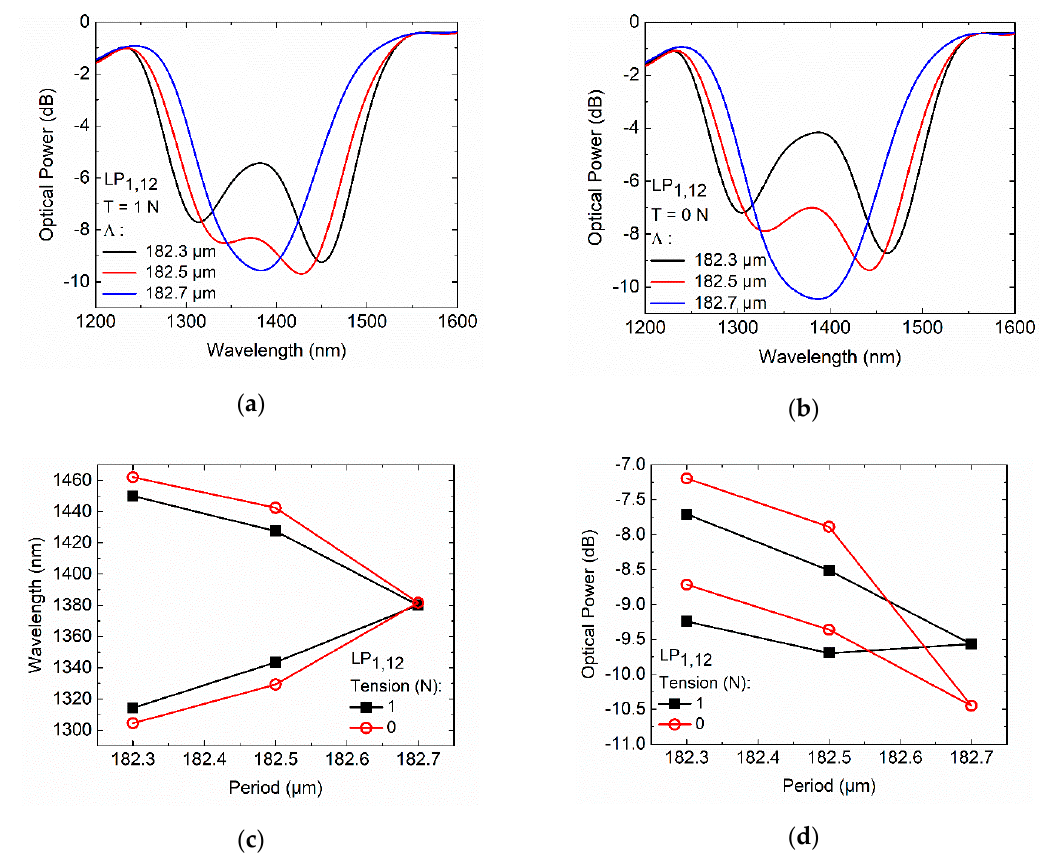
Figure 5. Fs laser turning around point (TAP) LPFGs higher order asymmetric cladding mode (LP 1,12 ), inscribed in the SMF-28e fiber: ( a ) spectra under fabrication tension of 1 N; ( b ) spectra without tension; ( c ) resonance wavelengths versus grating period; ( d ) optical power versus grating period.